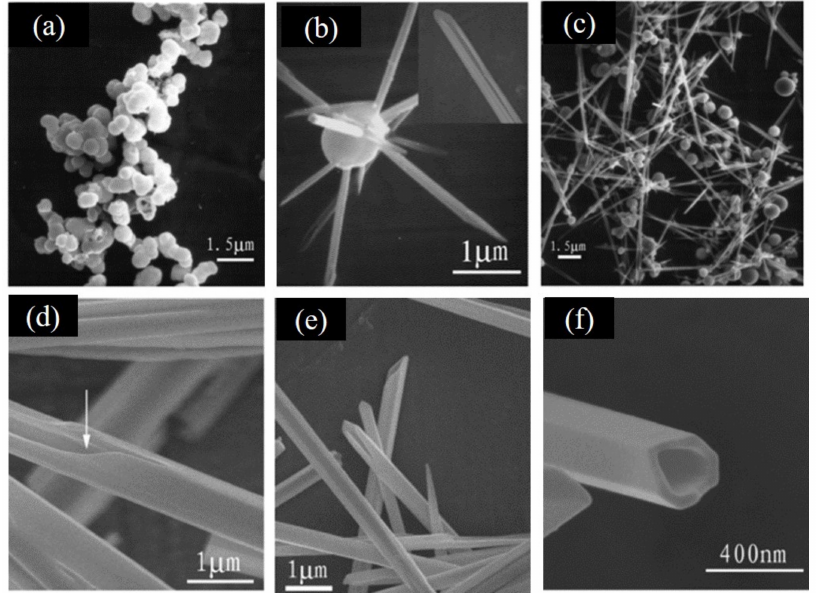
Figure 6. SEM images of five Te NTs samples collected after hydrothermal treating for ( a ) 5 h, ( b ) 8 h, ( c , d ) 12 h, ( e ) 16 h, and ( f ) 20 h, supporting the NDRG mechanism. Reprinted with permission from [37]. Copyright 2004, American Chemical Society, Washington, DC, United